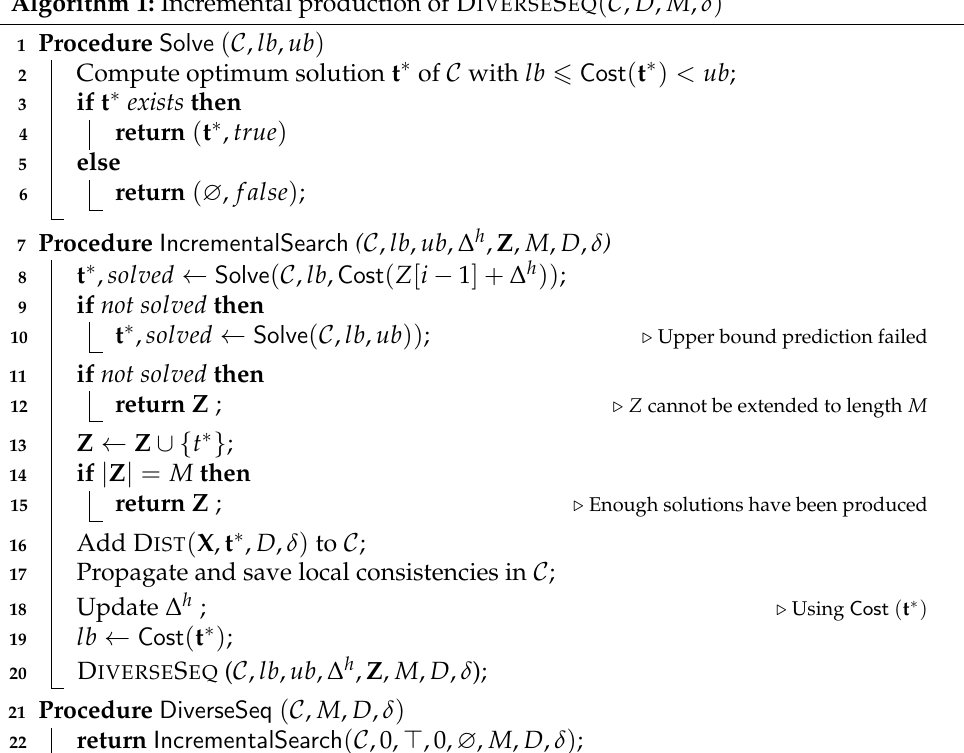
Algorithm 1: Incremental production of D IVERSE S EQ ( C , D , M , δ